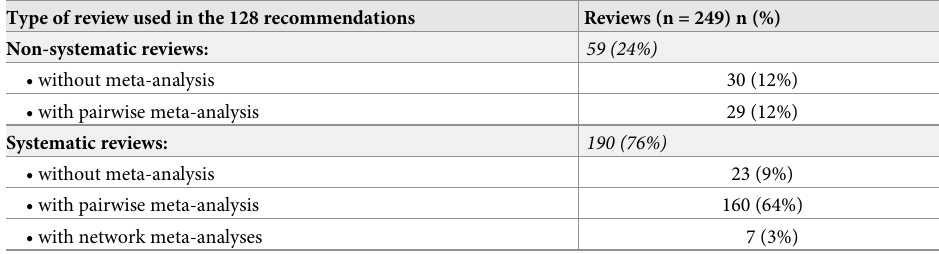
Table 5. Type of review used in 128